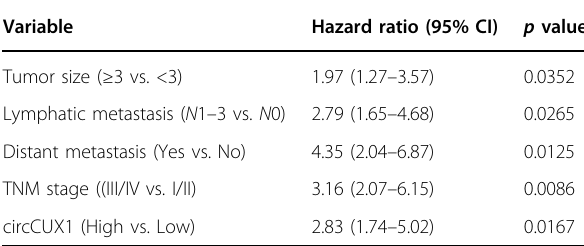
Table 4 Multivariate analysis of independent prognostic factors of